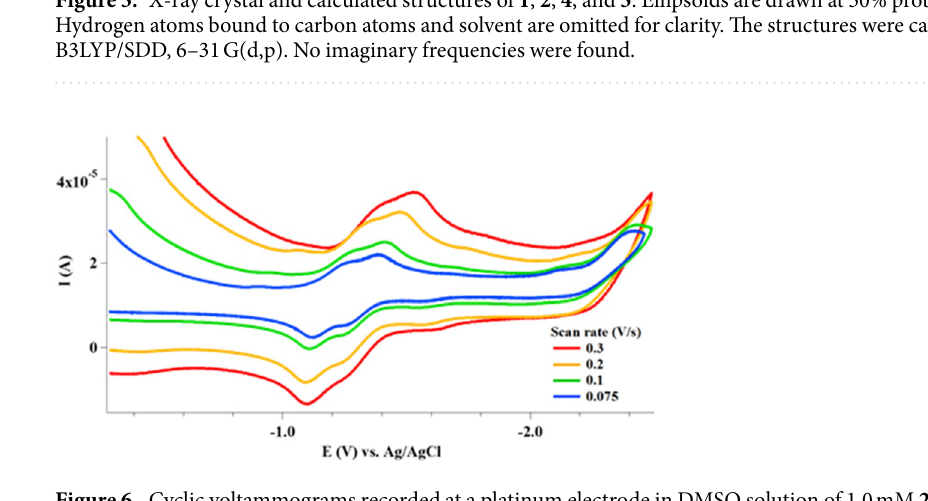
Figure 6. Cyclic voltammograms recorded at a platinum electrode in DMSO solution of 1.0 mM 2 , with NaClO 4 supporting electrolyte; scan rate 0.3, 0.2, 0.1, and 0.075 V sec − 1